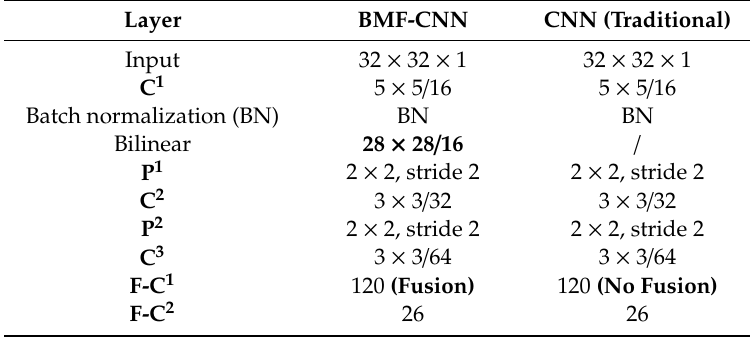
Table 1. Detailed parameters of BMF-CNN and baseline CNN